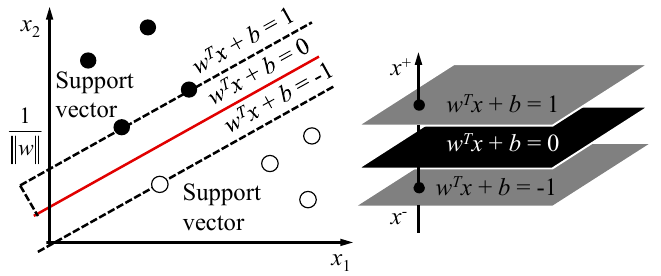
Figure 11. Concept of support vector machine.